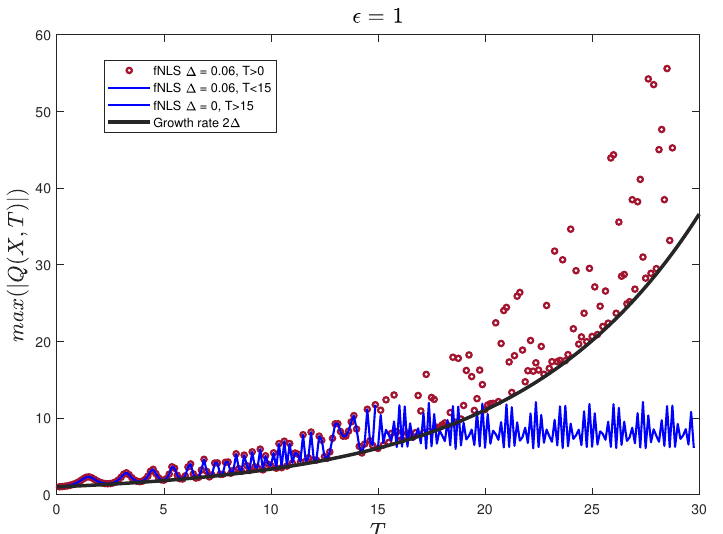
Figure 14. Case 3: Maximum of | Q ( X , T ) | and growth rate 2 ∆ when γ = 0.5, (cid:101) = 1.0, M = 1 and ∆ = 0.06. The forcing is turned off when T >